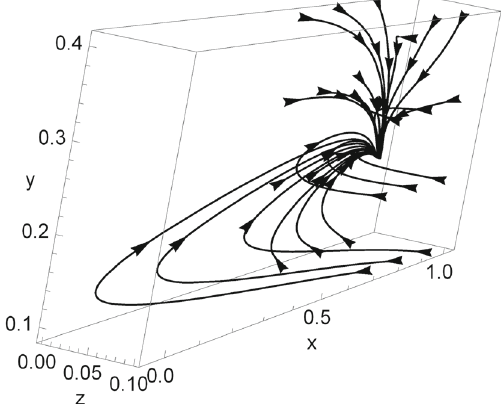
Fig. 7 The figure describes the evolution in the 3D space for various initial conditions, towards the A cosmological solution lution towards an era where the tachyon field tracks matter is displayed in Fig. 8, a particular solution with the following corresponding eigenvalues: ( − 5 . 48 , − 1 . 49 , − 0 . 01 ) . In this case the effective equation of state is equal to w m = − 0 . 01 and the matter density parameter is satisfying (cid:12) m = 0 . 3. The solution describe a hyperbolic critical point where the dynamics corresponds to a stable